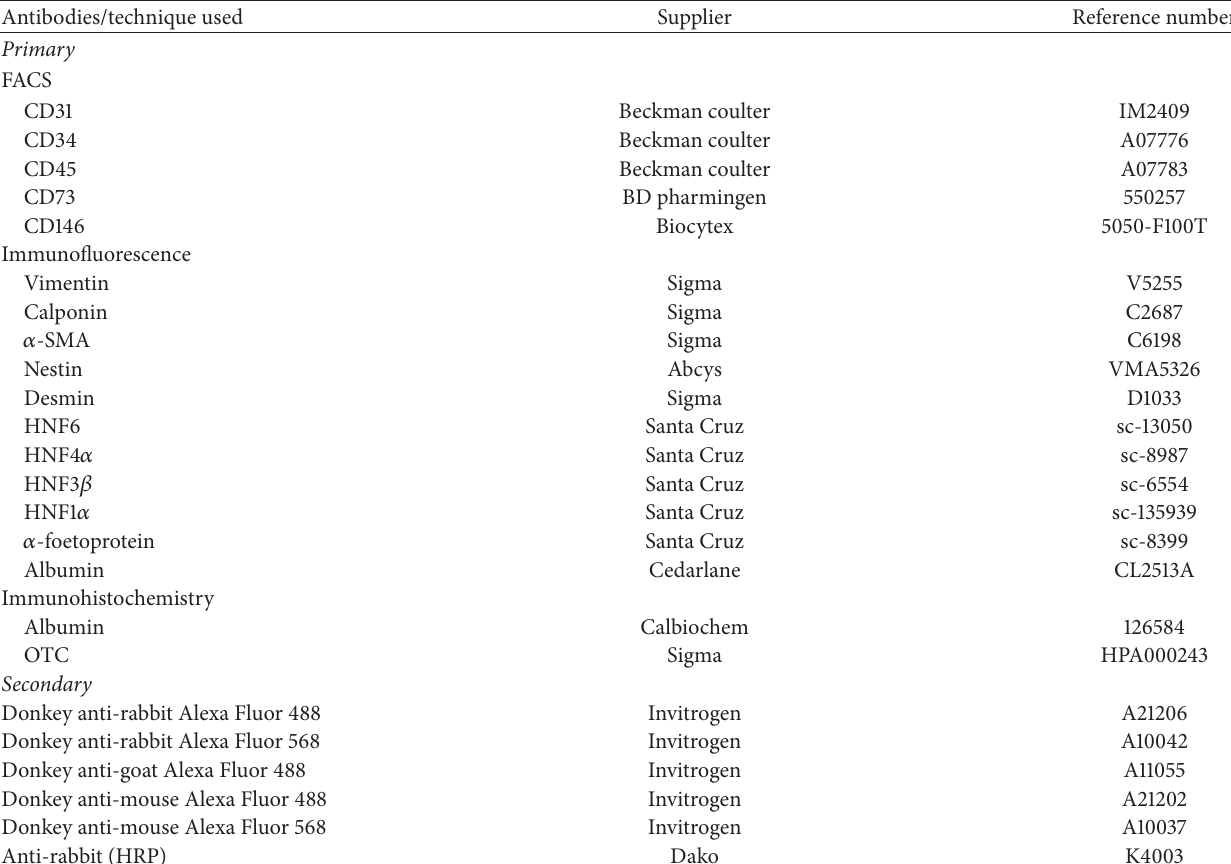
Table 1: Antibodies used in this